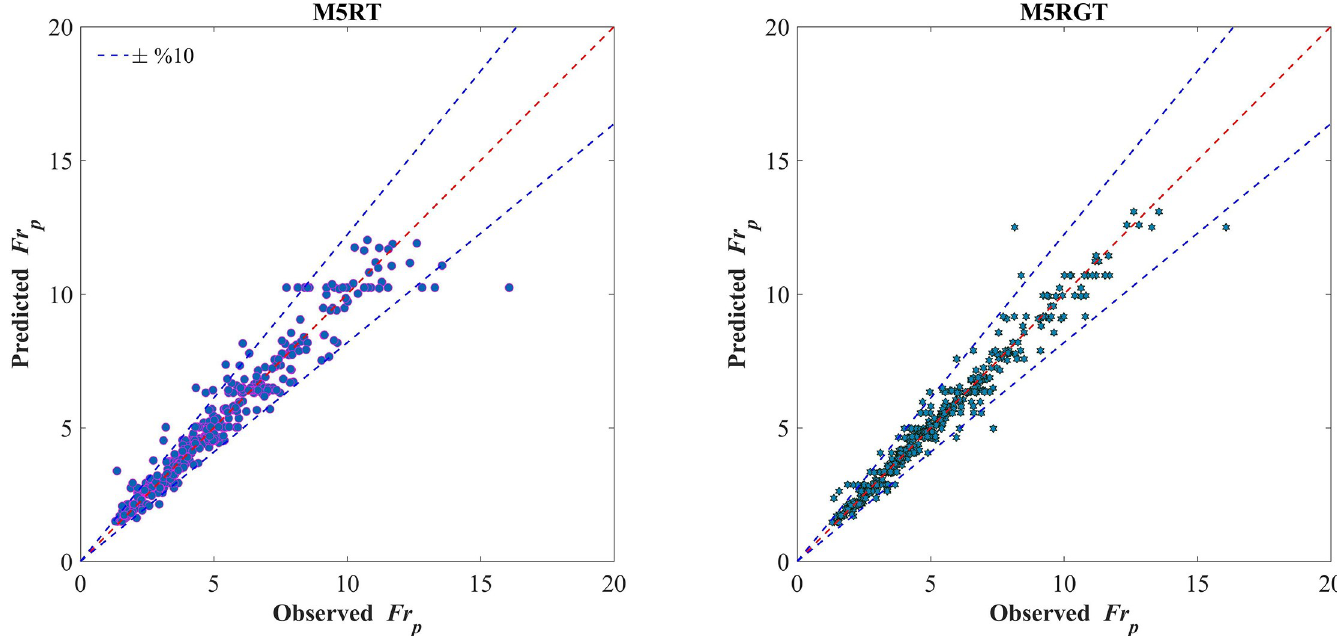
Fig 2. Scatter plots of observed and predicted particle Froude numbers for the training stage.